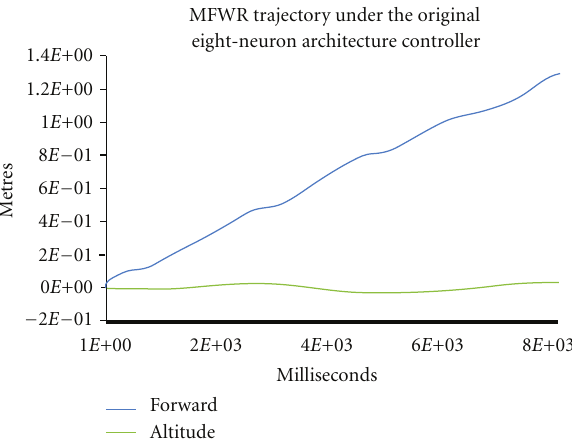
Figure 27: The MFWR trajectory produced by the reduced six- neuron controller. It can be observed that the architectural reduced controller was successful in producing qualitatively same cruise behavior possiblely by the fully connected eight-neuron network. The MFWR trajectory produced by the eight-neuron network is shown in Figure 24.